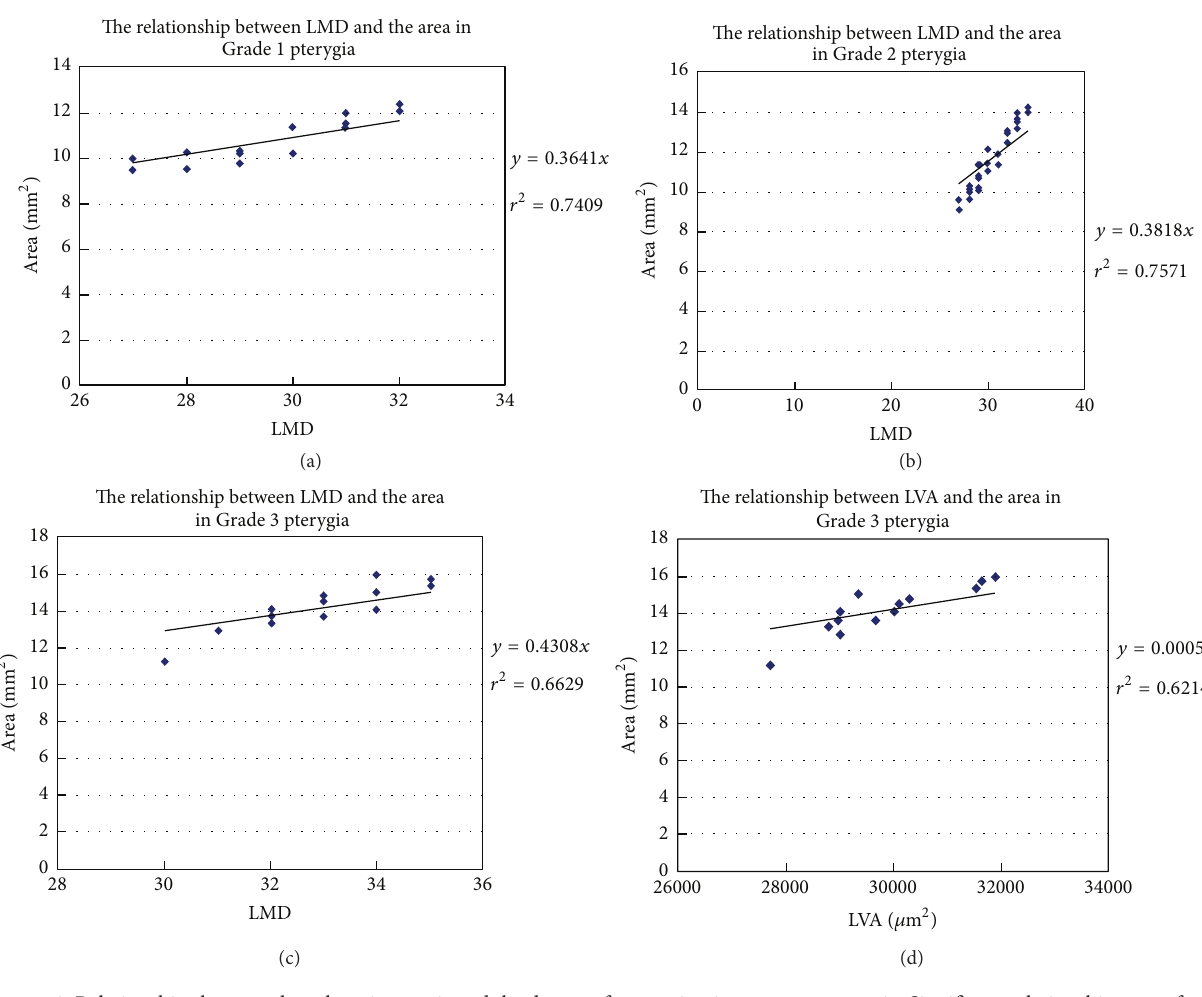
Figure 2: Relationships between lymphangiogenesis and the degree of aggression in recurrent pterygia. Significant relationships were found between LMD and pterygium area in Grade 1 pterygia ((a); 𝑟 2 = 0.7409 , 𝑝 < 0.05 ) and Grade 2 pterygia ((b); 𝑟 2 = 0.7571 , 𝑝 < 0.05 ). In Grade 3 pterygia, in addition to a significant relationship between LMD and pterygium area ((c); 𝑟 2 = 0.6629 , 𝑝 < 0.05 ), LVA was also significantly correlated with pterygium area ((d); 𝑟 2 = 0.6214 , 𝑝 < 0.05